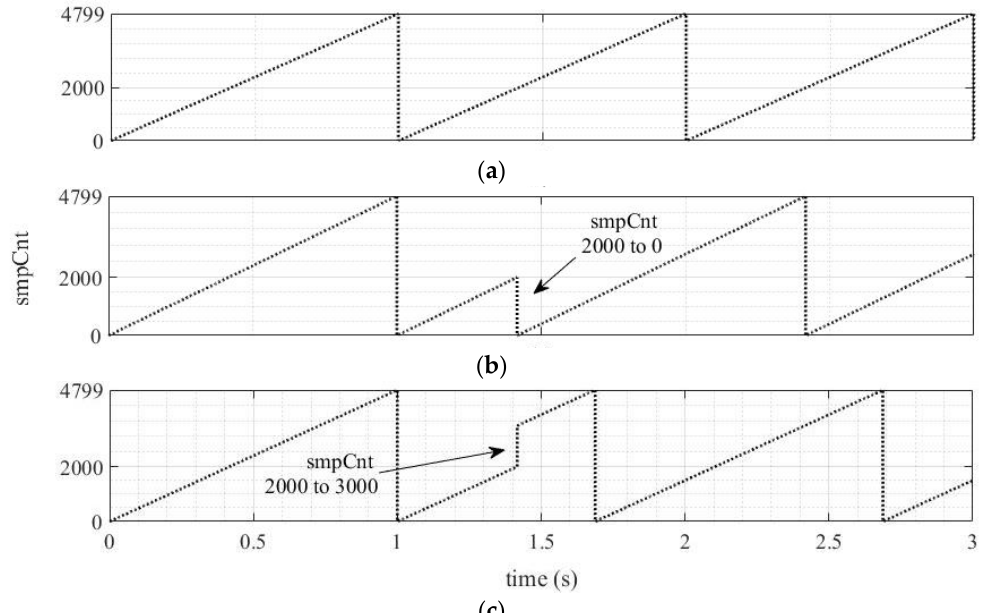
Figure 5. smpCnt value ( a ) without manipulation; ( b ) with reduction in the value of smpCnt; ( c ) with increase in the value of smpCnt.